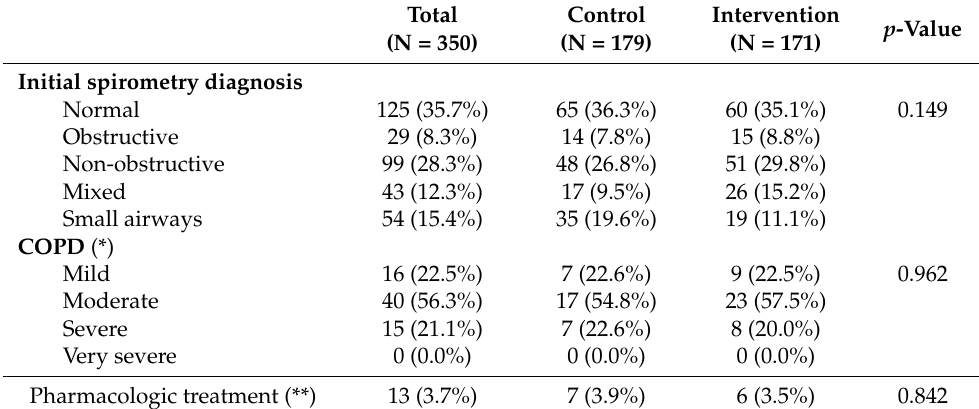
Table 2. Spirometry diagnosis at study intake: comparison of the two groups. Total